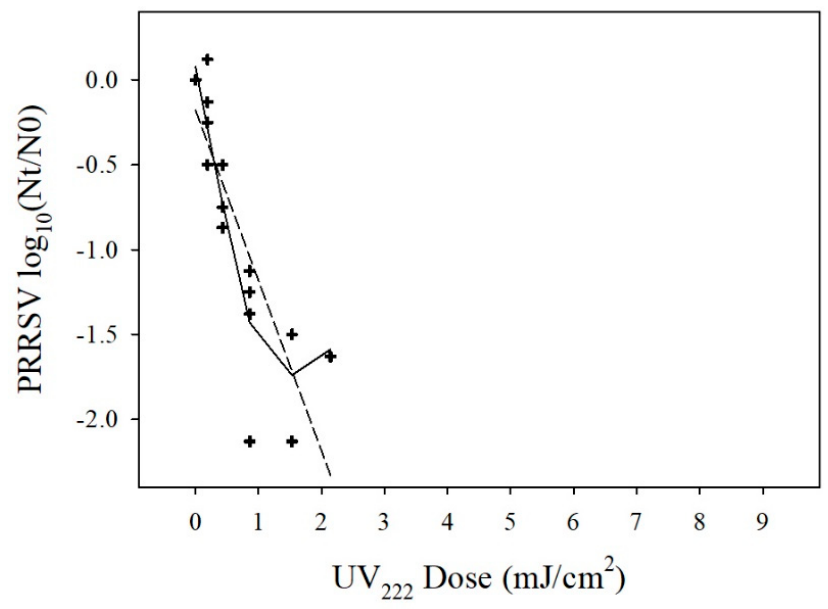
Figure A2. UV-C (222 nm) treatment inactivation curve on aerosolized PRRSV. One-stage (dashed line) and two-stage (solid line) inactivation curves were drawn. PRRSV survival is expressed as log 10 (N t /N 0 ), not as a percentage (%) as shown in Figure 3.